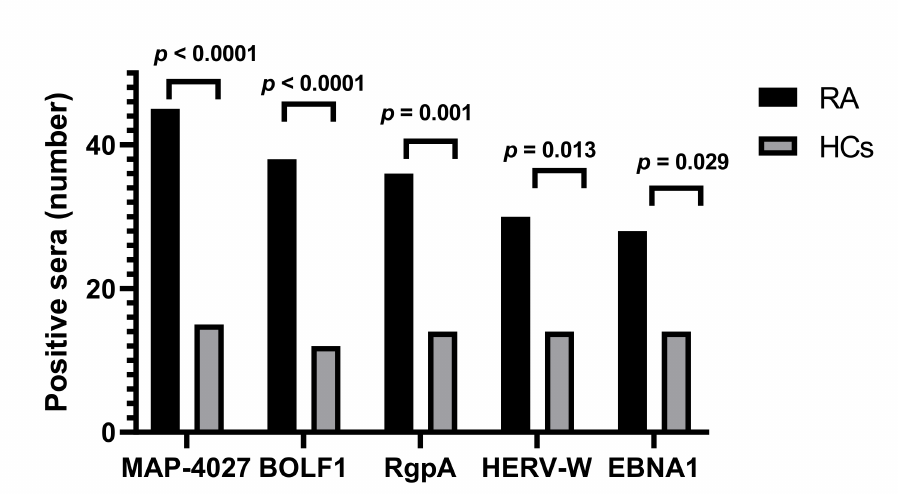
Figure 2. Number of sera positive to MAP4027, BOLF1, RgpA, HERV-W, and EBNA1 peptides in RA and HCs (Fisher’s exact test: p < 0.05).